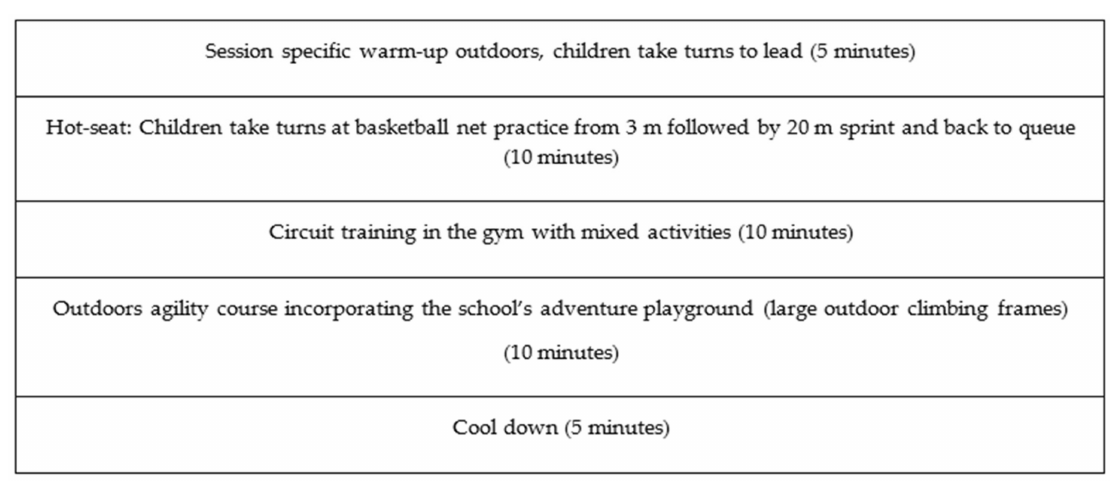
Figure A1. A moderate to high intensity exercise